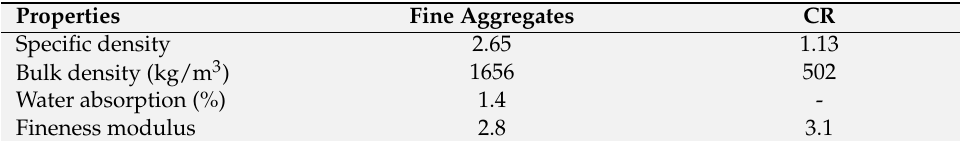
Figure 3. PSD curve of fine aggregates and CR. Table 4. Physical properties of fine